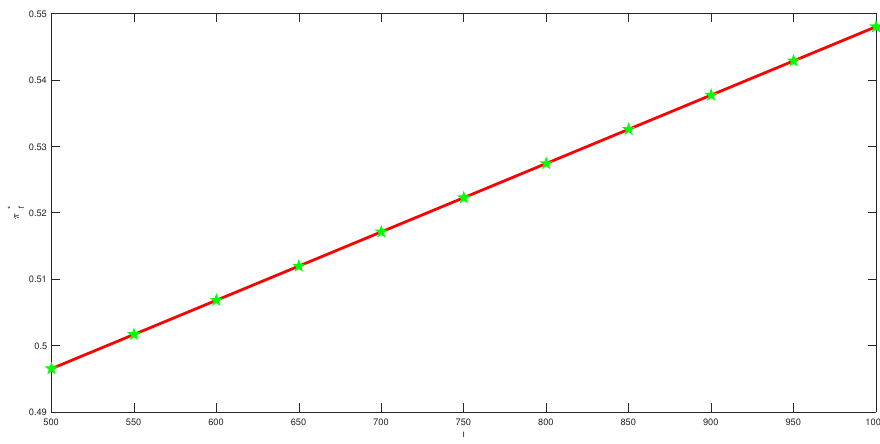
Figure 1. Effects of parameter l on π ∗